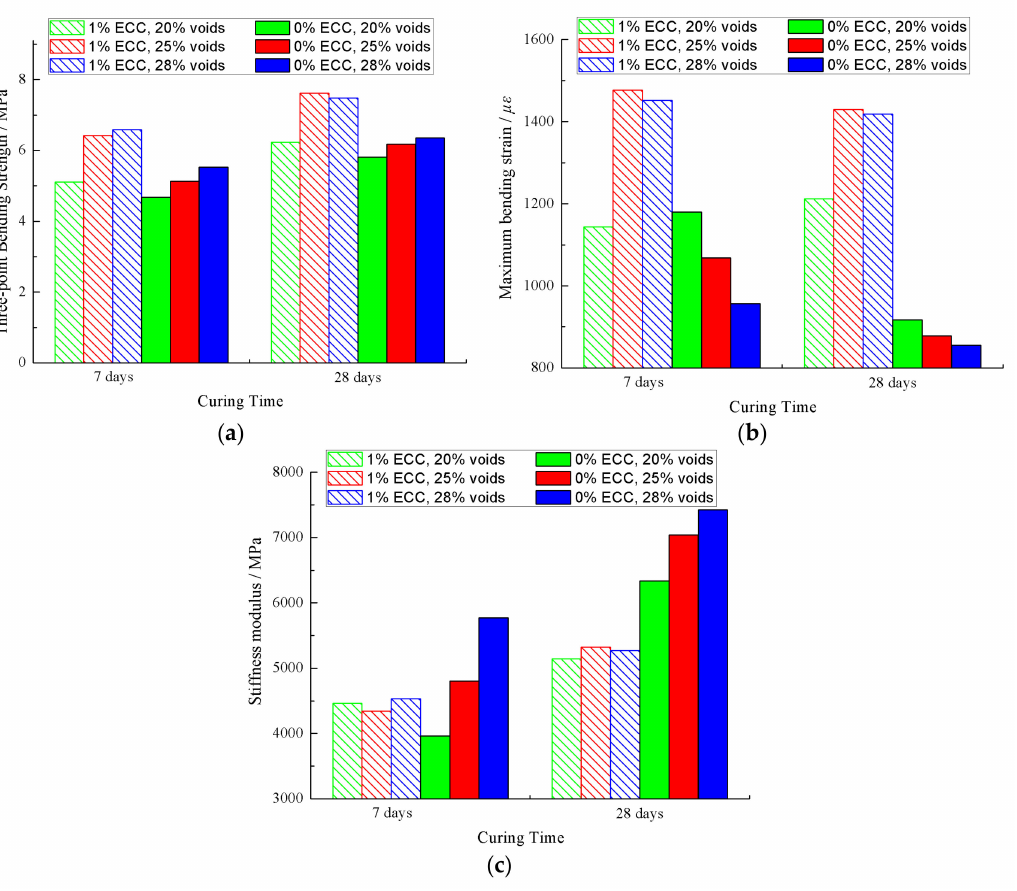
Figure 11. Results of the three-point bending test. ( a ) Results of three-point bending strength; ( b ) Results of maximum bending strain; ( c ) Results of sti ff ness